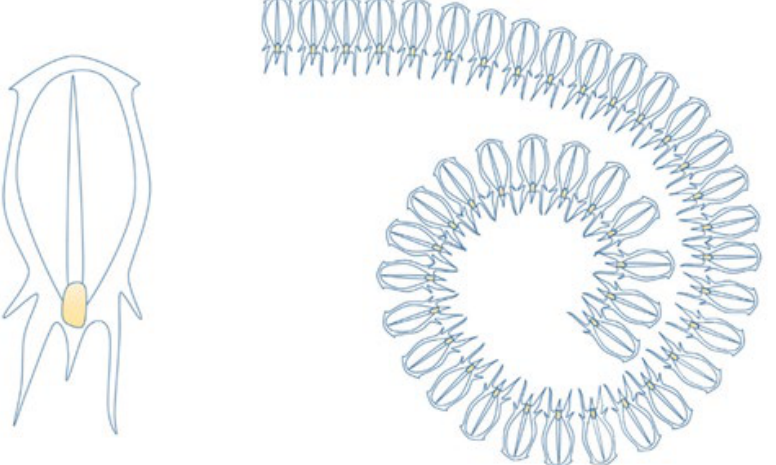
Figure 3. Individual salp and swam of salps .